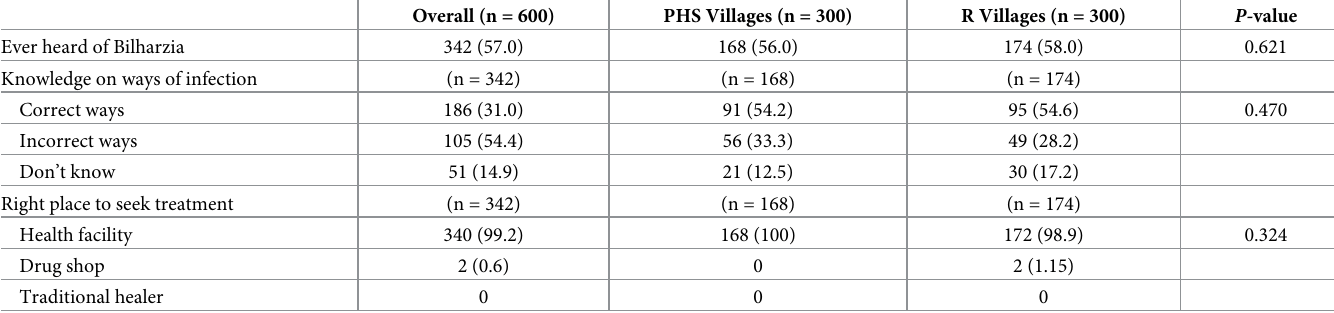
Table 7. Knowledge and practice on schistosomiasis among adult